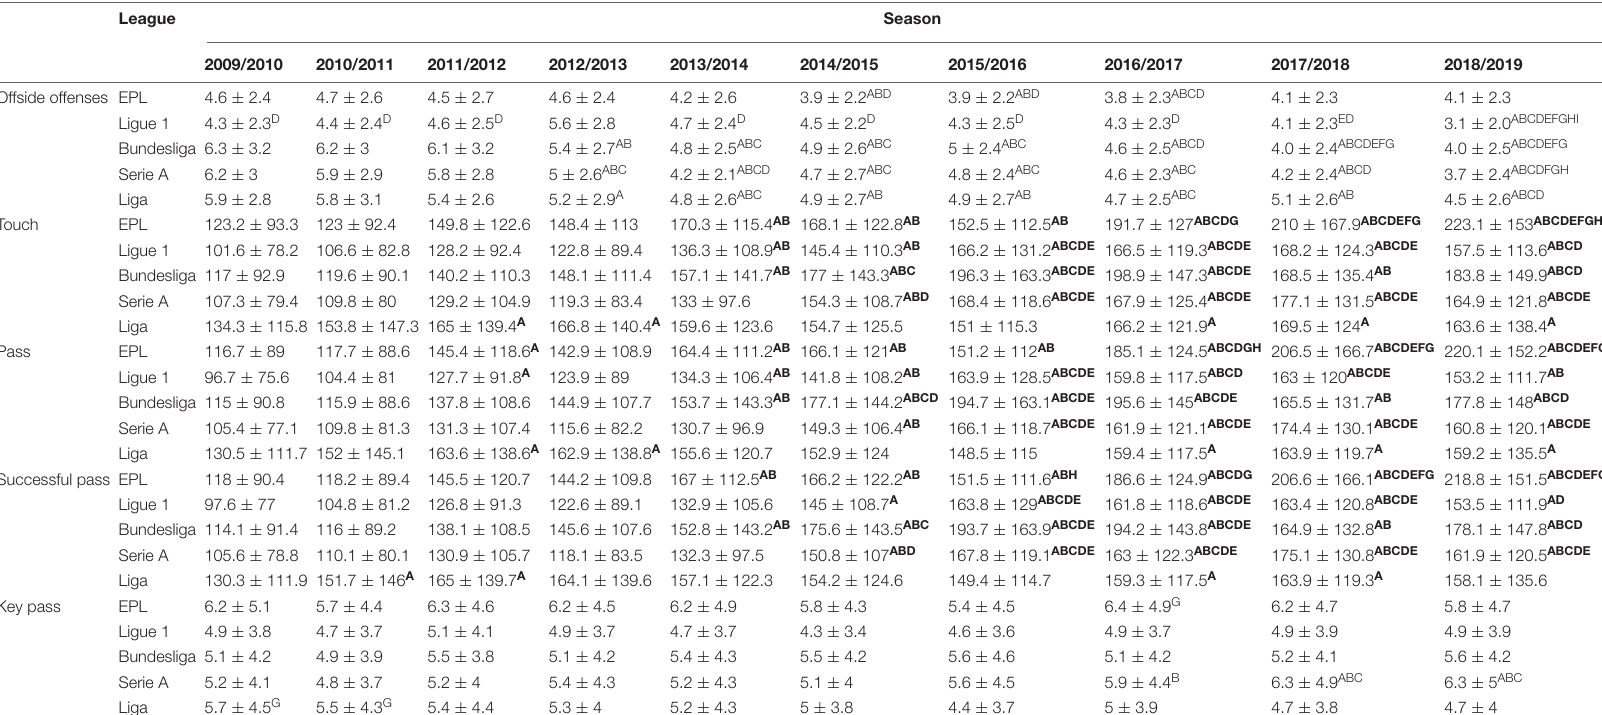
TABLE 2 | Offside offenses and passing performance across 10 seasons for European Big five leagues.